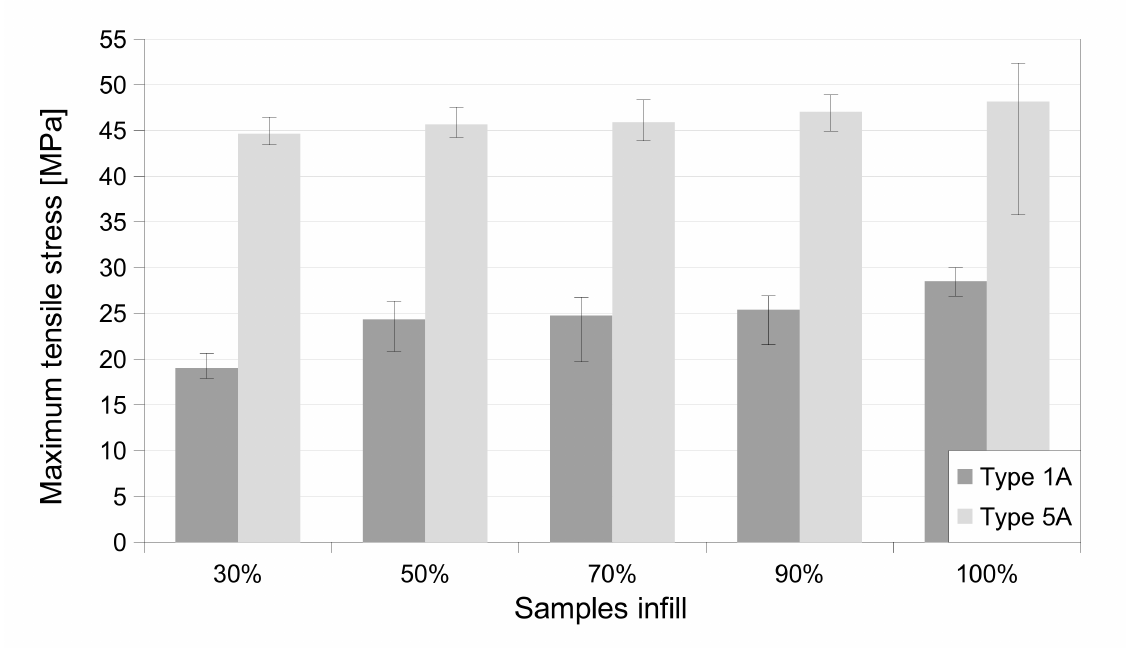
Figure 9. The influence of the sample type and infill density on the mechanical properties of the printed